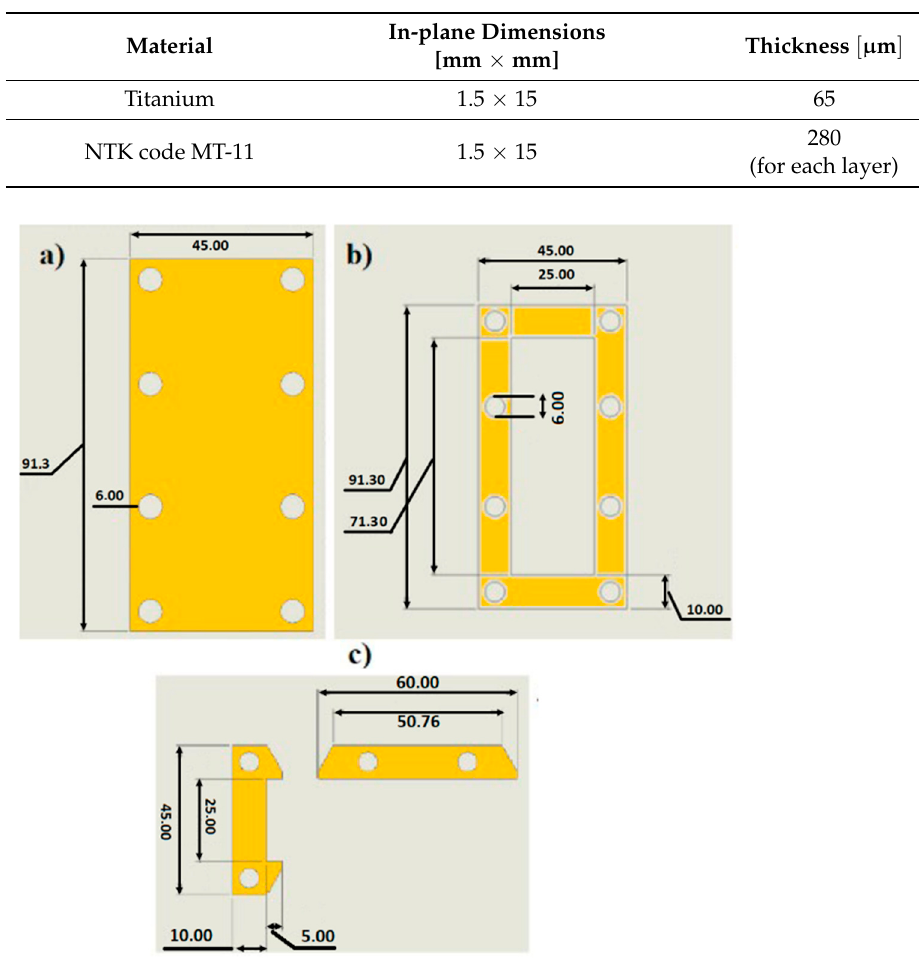
Figure 11. Experimental setup: mechanical frame installed on the rotation stage.